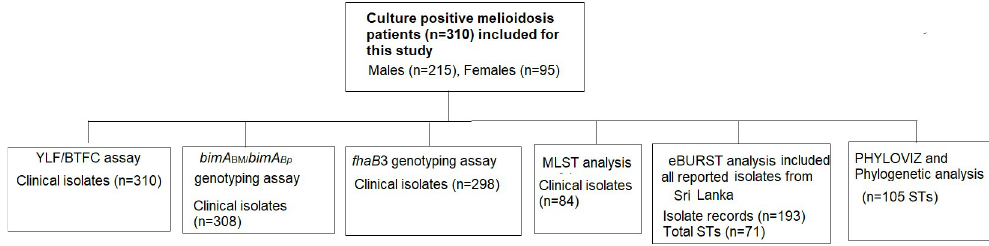
Fig 2. Flowchart demonstrating genotyping and analyses of clinical isolates.